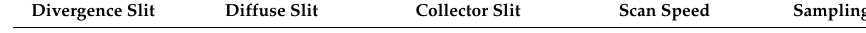
Table 6. Basic parameters of X-ray diffraction test.